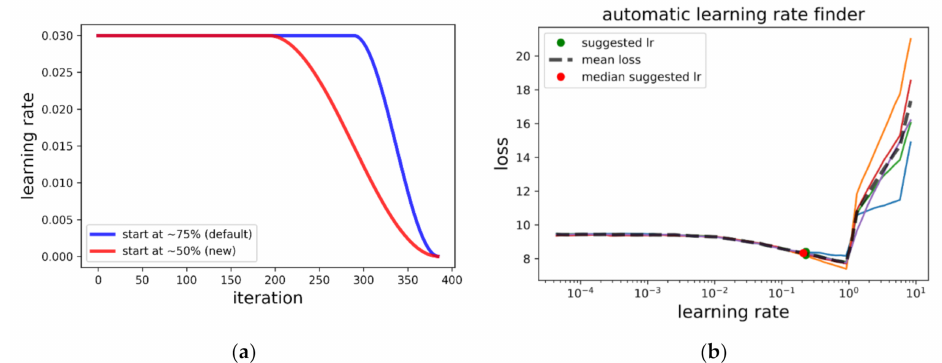
Figure 6. ( a ) Flat + cosine annealing (fca) learning rate schedule. The learning rate is kept steady for a certain percentage of the iterations and decreased afterwards. ( b ) Finding the optimal learning